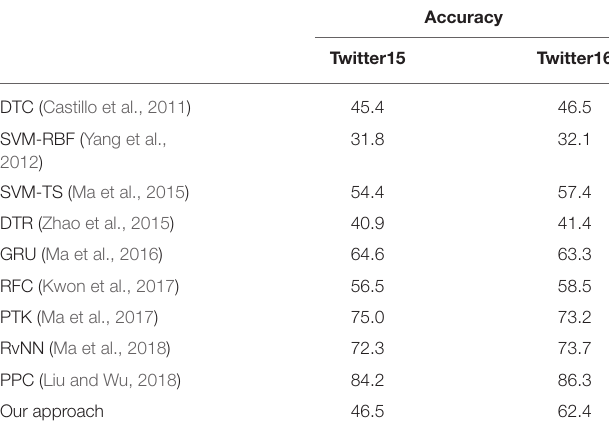
TABLE 8 | Baseline models classification results for Twitter15 and Twitter16